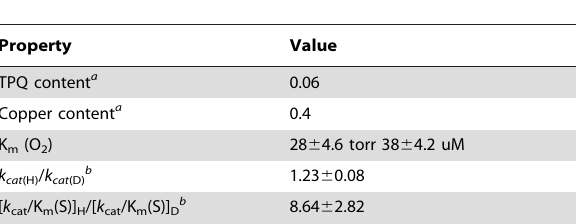
Table 1. Properties of purified human AOC3.